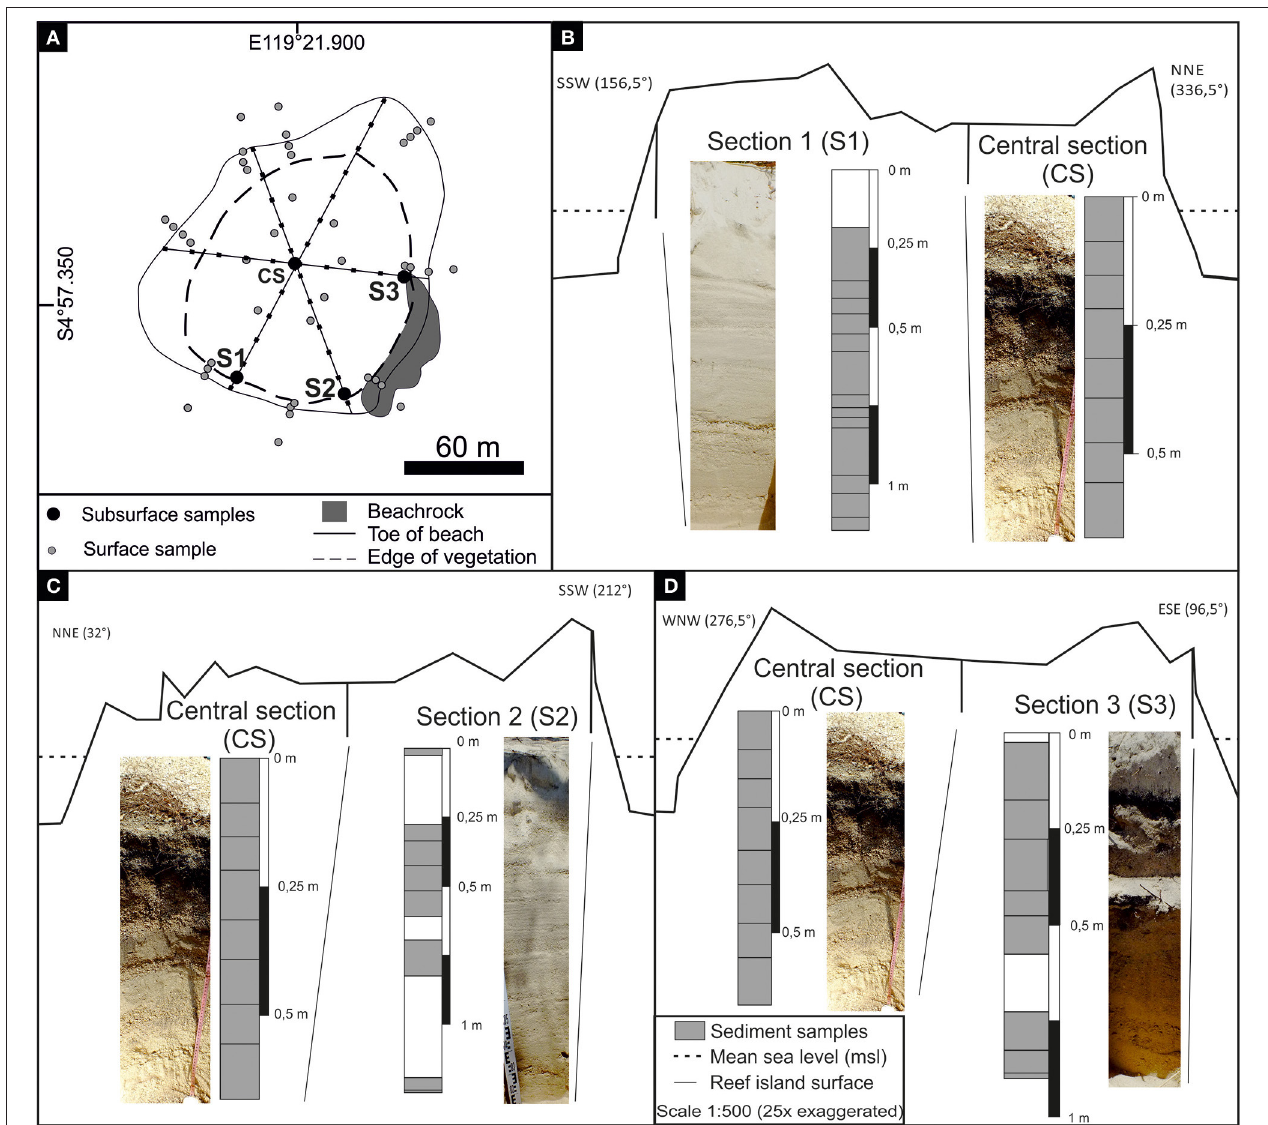
FIGURE 3 | (A) Map of P. Panambungan indicating surface and subsurface sampling locations. The subsurface sampling location Central section (CS) is situated in the center of the island. Transects display the geomorphology of P. Panambungan. (B) One transect crosses the island from SSW to NNE, with subsurface sampling location Section 1 (S1) and CS. (C) The NNE-SSW trending transect includes subsurface sampling location CS and Section 2 (S2). (D) In WNW-ESE trending transect subsurface sampling locations Section 3 (S3) and CS are covered. Subsurface sampling locations are shown with corresponding sampling site image and a profile bar, with gray areas indicating sampling depths.